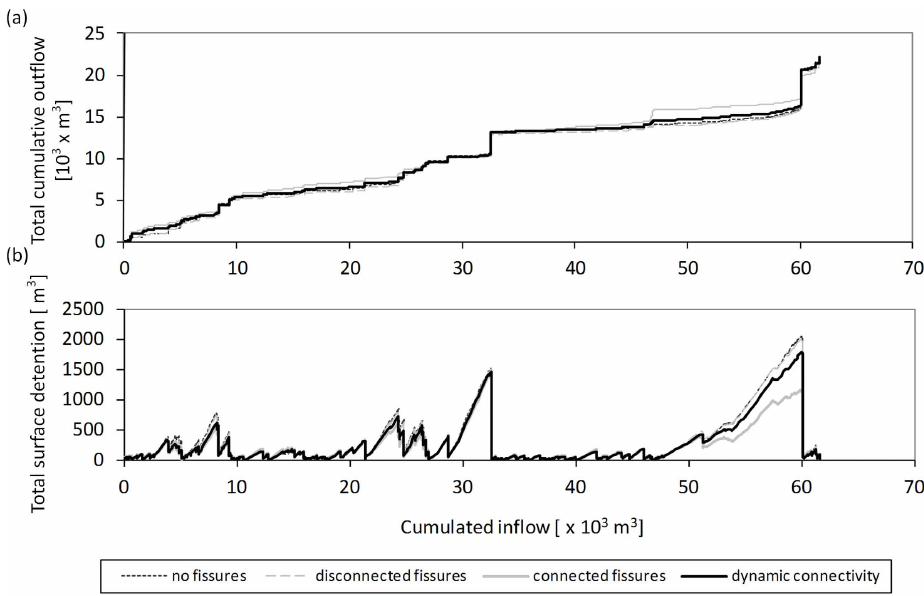
Fig. 5. Variation in total cumulative outflow and total surface detention during one-year simulation period expressed in relationship to cumulative inflow (total rain